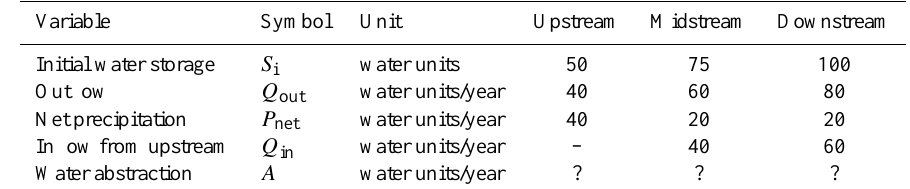
Table 2. Variables in the River Basin Game with their values for year 1.